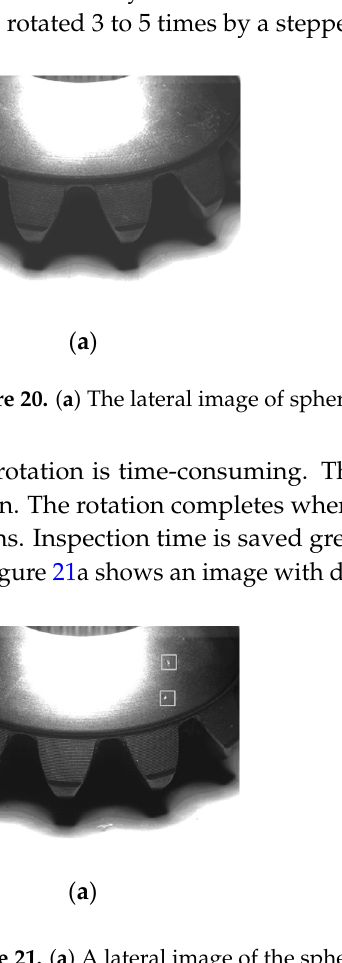
Figure 19. Defect detection of top ring on bottom surface: ( a ) Top ring extraction; ( b ) Top ring fitting (red circles); ( c ) Result of defect detection; ( d ) Defects after open-operation.